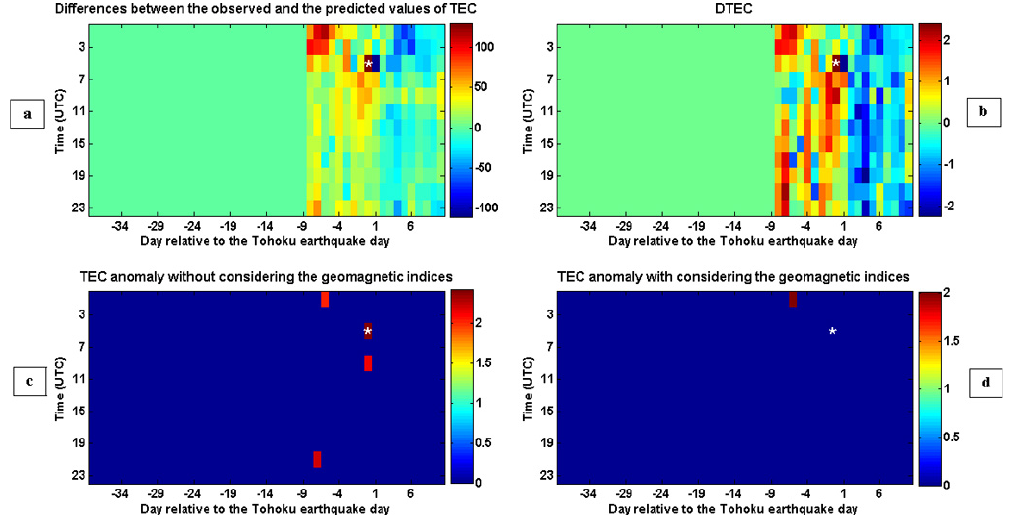
Fig. 4. (a) Differences between the observed and the predicted values of TEC. (b) DTEC variations. (c) Detected anomalies without consid- ering the geomagnetic indices. (d) Detected anomalies with considering the geomagnetic indices.